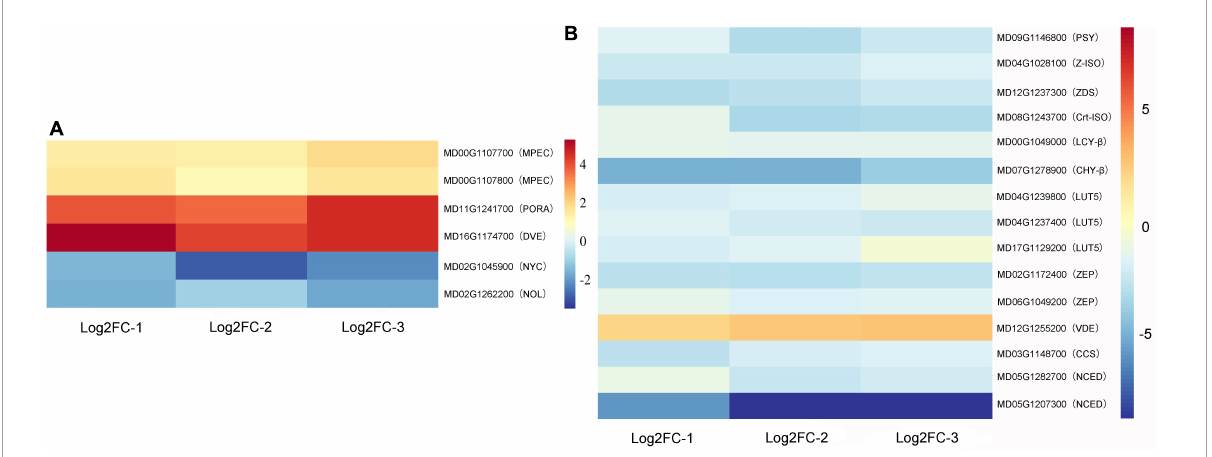
FIGURE3 Heat maps of chlorophyll and carotenoid-related DEGs after waxing treatment in apple fruit. Selected DEGs related to chlorophyll (A) and carotenoid (B) from RNA-Seq date. Log2FC-1, Log2 (Fold Change) value of Waxed-1 and Control-1 in apple fruit RNA-Seq; Log2FC-2, Log2 (Fold Change) value of Waxed-2 and Control-2 in apple fruit RNA-Seq; Log2FC-3, Log2 (Fold Change) value of Waxed-3 and Control-3 in apple fruit RNA-Seq. The scale bar indicates upregulated (red) and downregulated (blue)